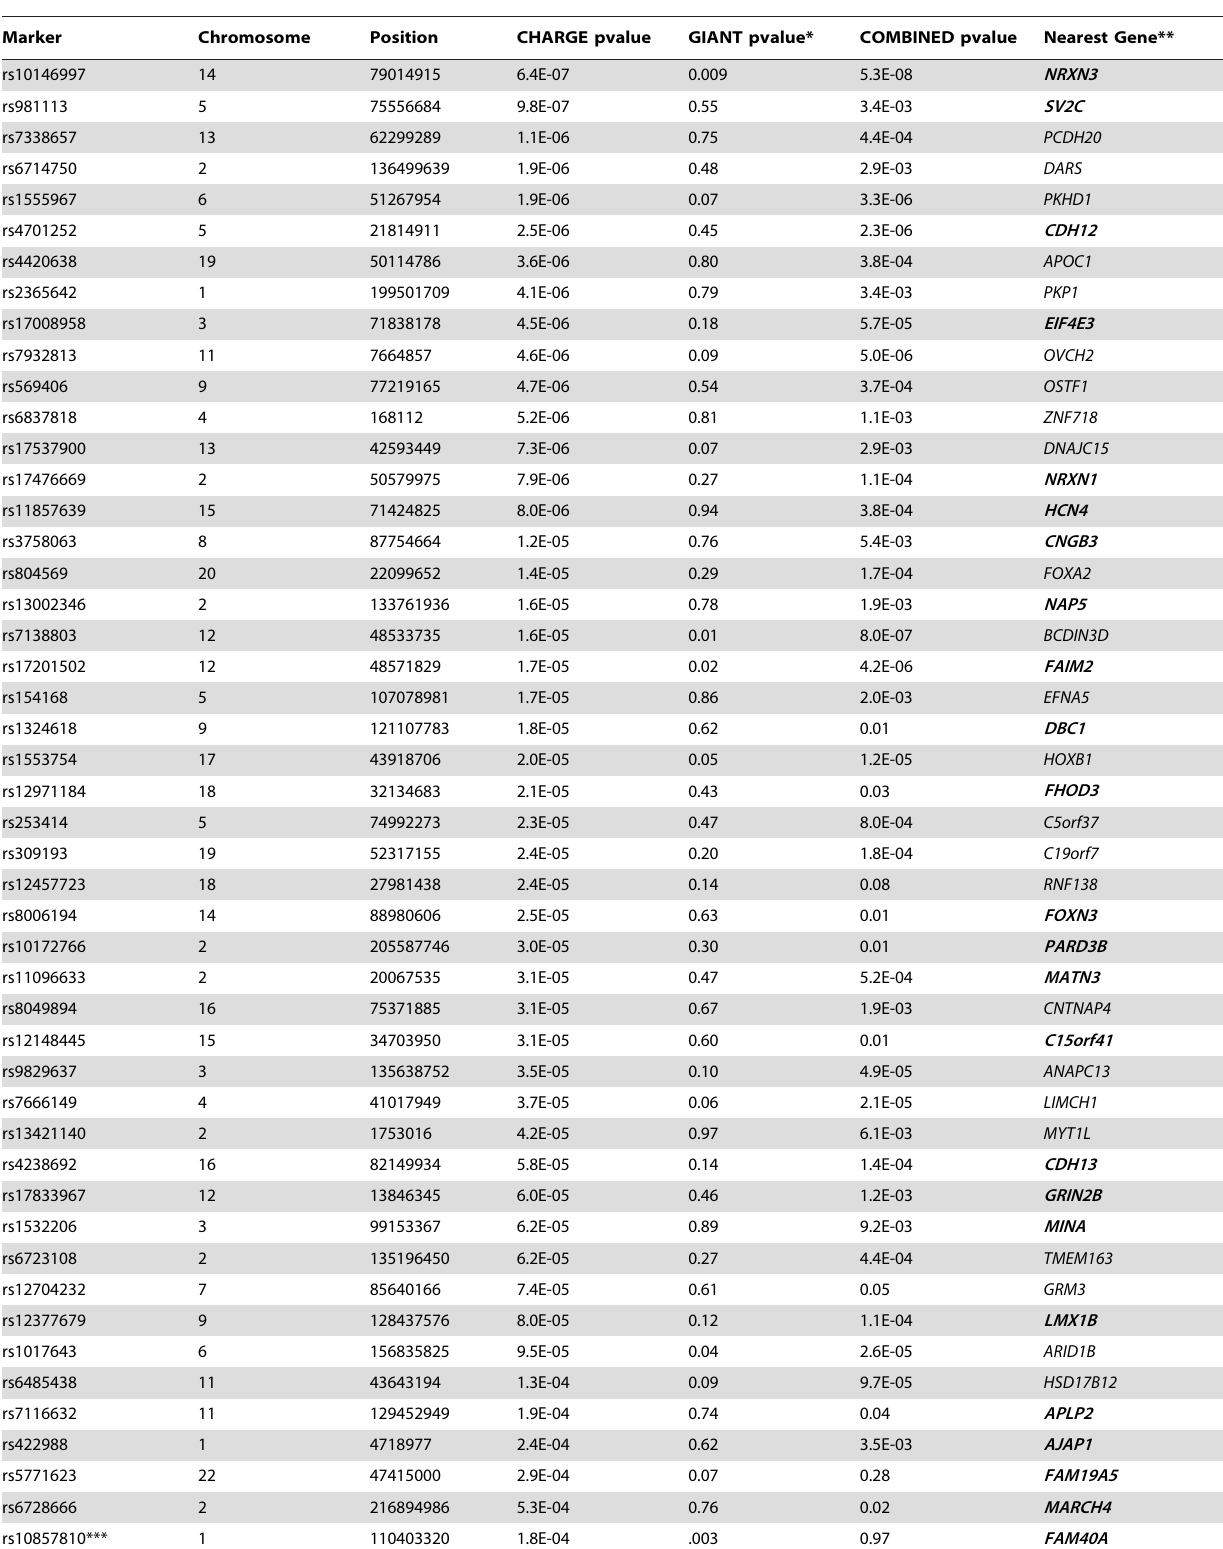
Table 2. Top 48 SNPs exchanged with the GIANT Consortium, GIANT p-values, and the combined results.